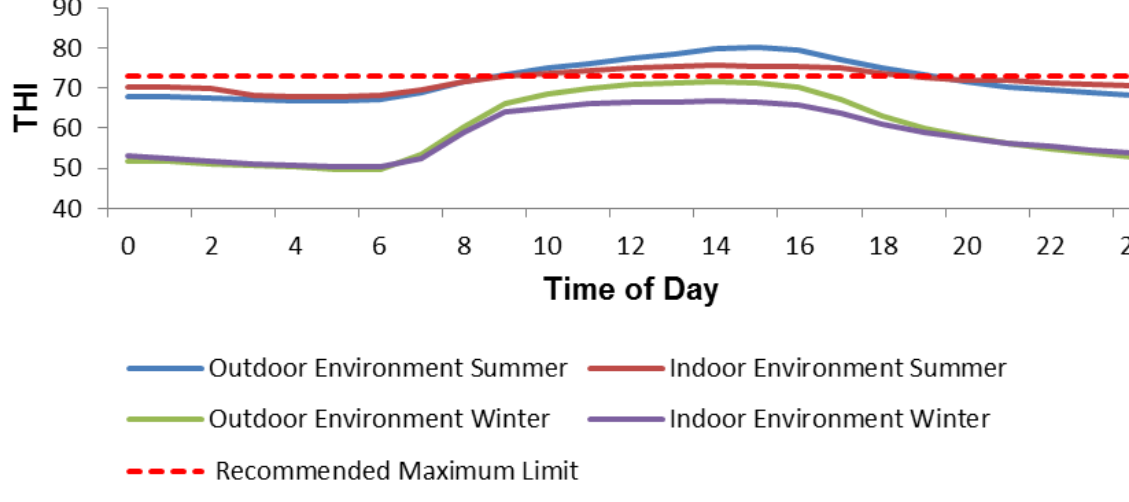
Figure 4. Variation of the hourly mean values of Temperature-Humidity index, inside the closed compostbedded pack barn (CBP), equipped with the EACS - Adiabatic Evaporative Cooling System, and in the external environment, throughout the experimental period of summer and